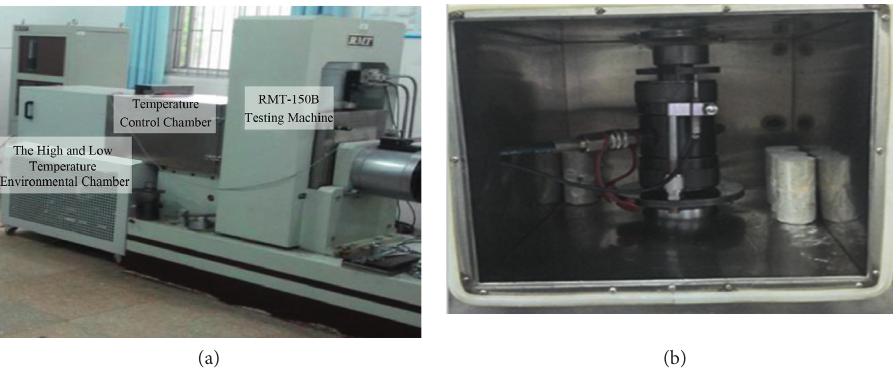
Figure 1: Test devices. (a) Assembled environmental chamber and RMT-150B testing machine. (b) Displacement sensor.